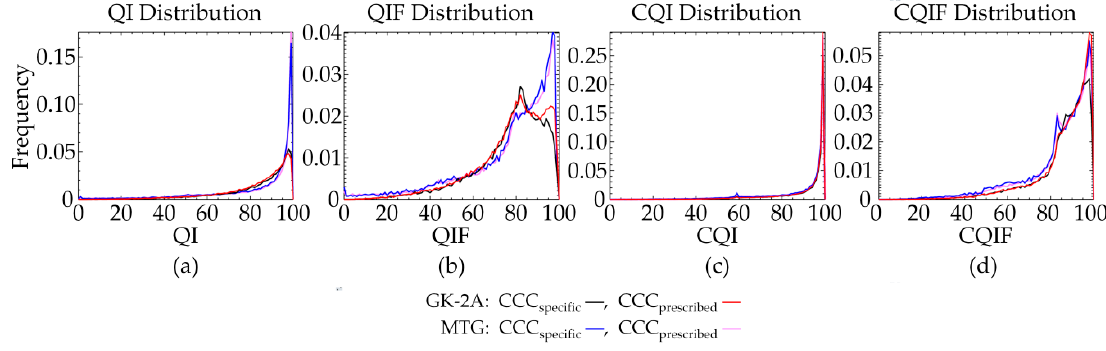
Figure 8. Distribution comparisons of ( a ) QI, ( b ) QIF, ( c ) CQI, and ( d ) CQIF of GK-2A and MTG AMVs for 12:10 UTC on 21 July 2016. The colors represent GK-2A AMVs with heights from CCC in the specific configuration ( black ) and CCC in prescribed configuration ( red ) as well as MTG AMVs with heights from the CCC in specific configuration ( blue ) and CCC in the prescribed configuration ( violet ). The results obtained for 05:40 UTC on 21 July 2016 were very